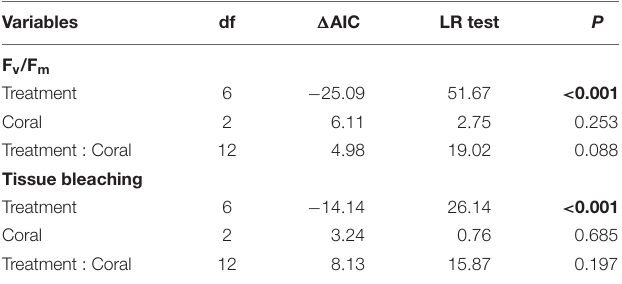
TABLE 1 | Summary of LME models on coral maximum quantum yield (F v /F m ) and percentage of coral tissue bleaching after 8 weeks of interactions with